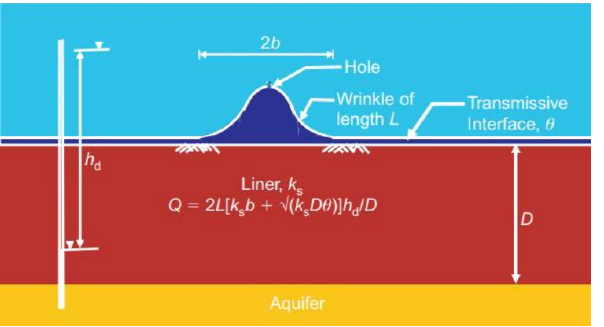
Figure 4. Schematic diagram of pollutant leakage from the hole connected with the wrinkle. Redrawn from Ref. [35].